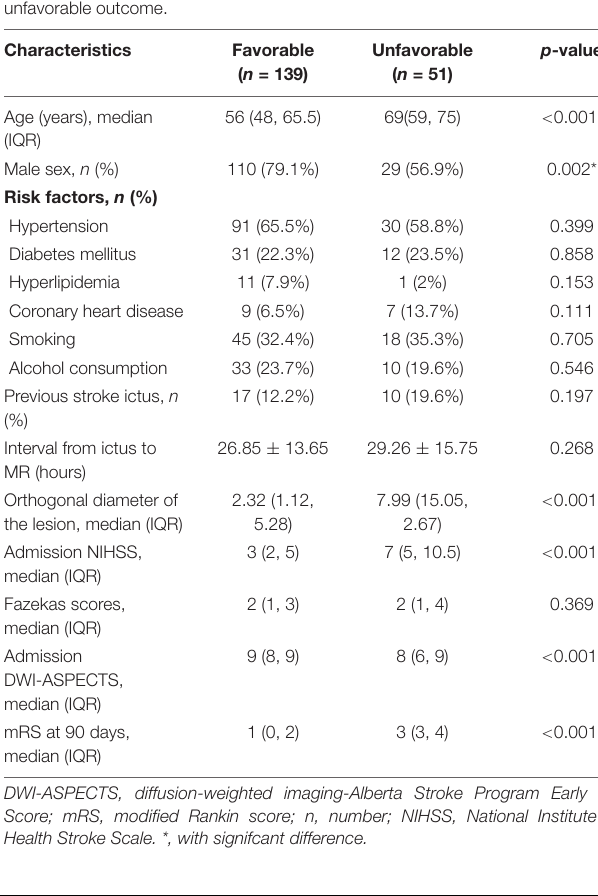
Frontiers in Neuroscience |